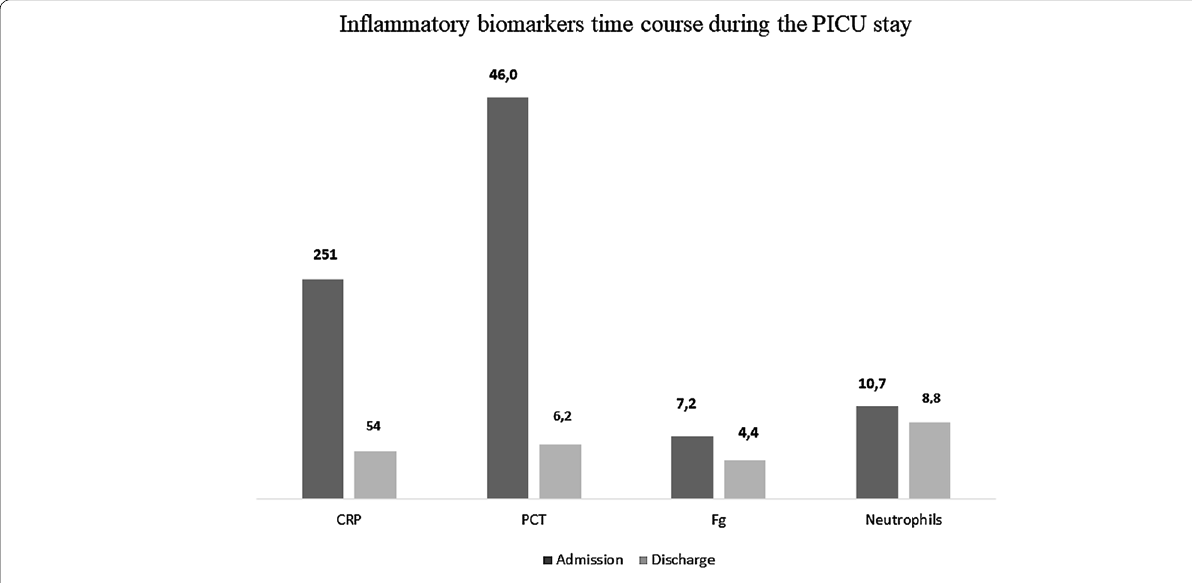
Fig. 1 Inflammatory biomarkers time course during the PICU stay. Laboratory values of CRP, PCT, and neutrophil count at PICU admission (black histograms) and discharge (grey